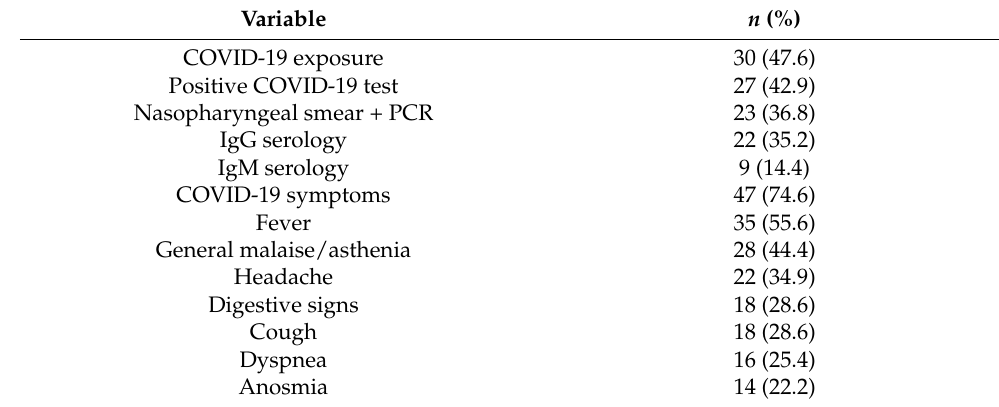
Table 2. Clinical and microbiological findings in patients with cutaneous lesions related to COVID-19 infection.